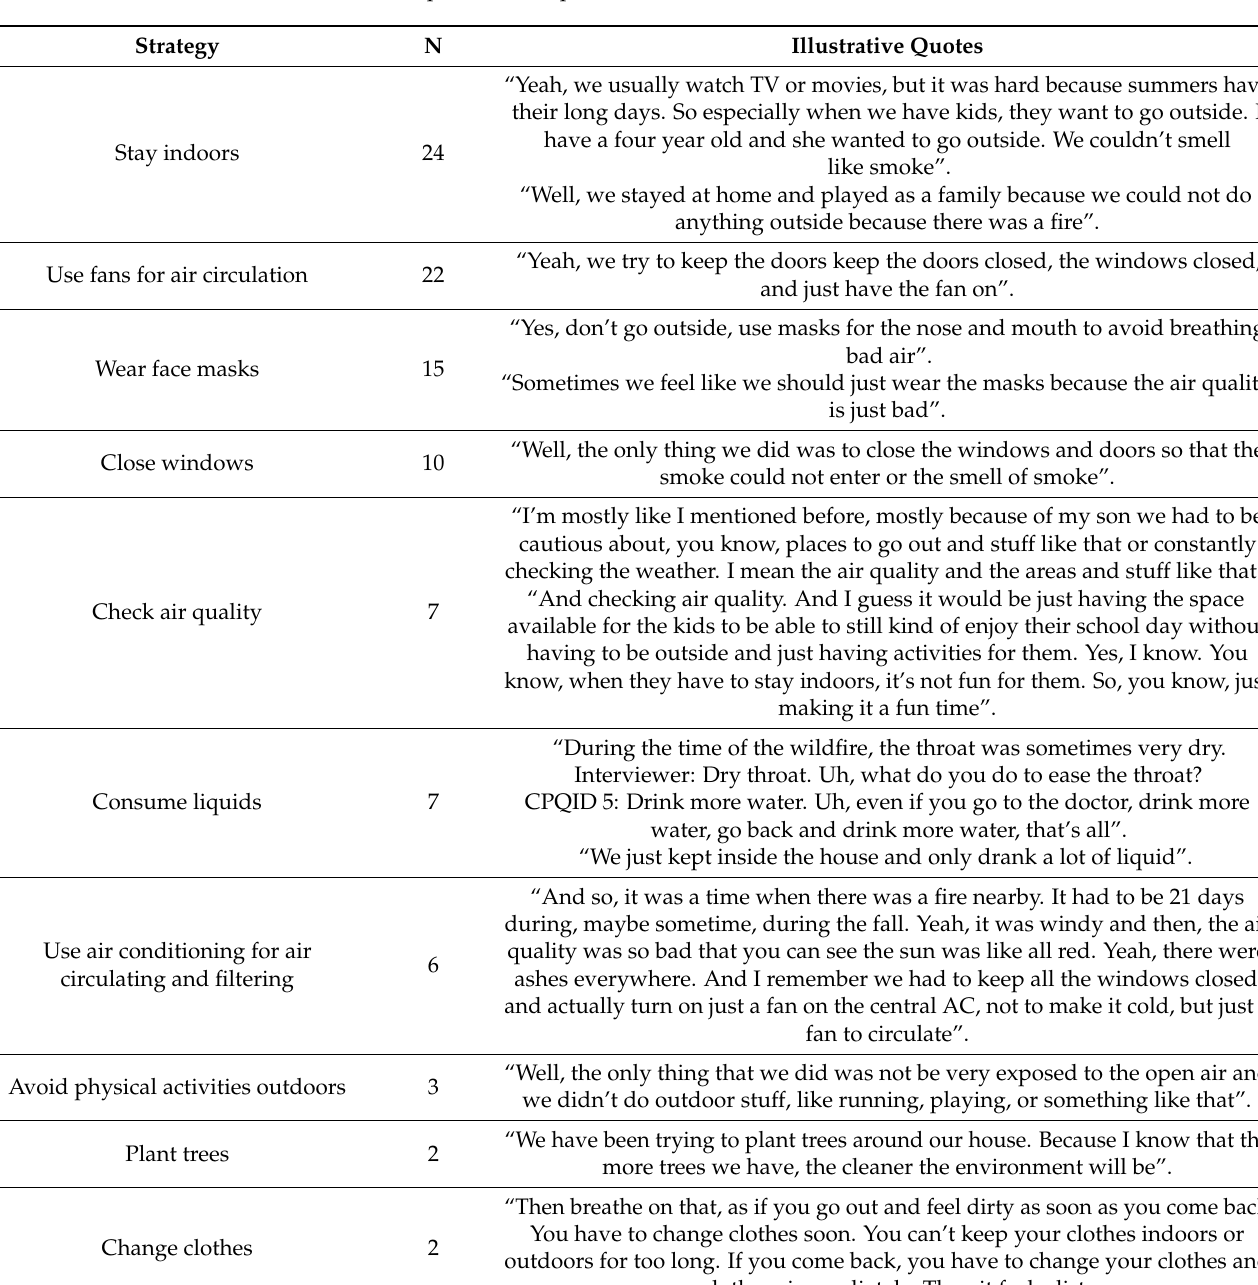
Table 3. Air pollution adaptation